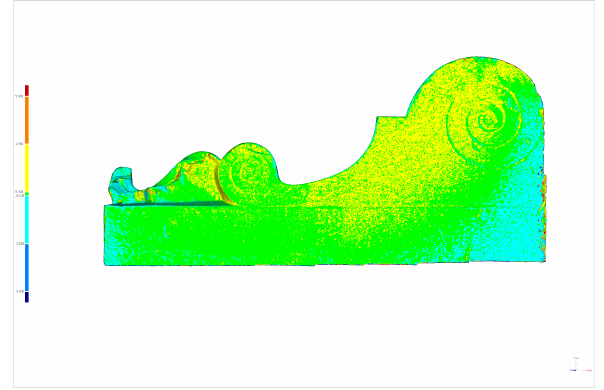
Figure 6. Results of 3d compare of